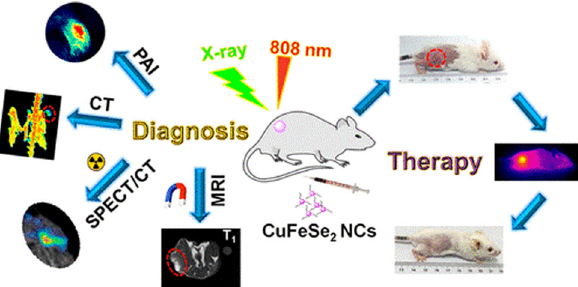
Figure 5: Illustration on the use of CuFeSe 2 ternary quantum dot ( TQD ) for multimodal imaging photothermal therapy of cancer; with permission from ref. [ 101 ] ;